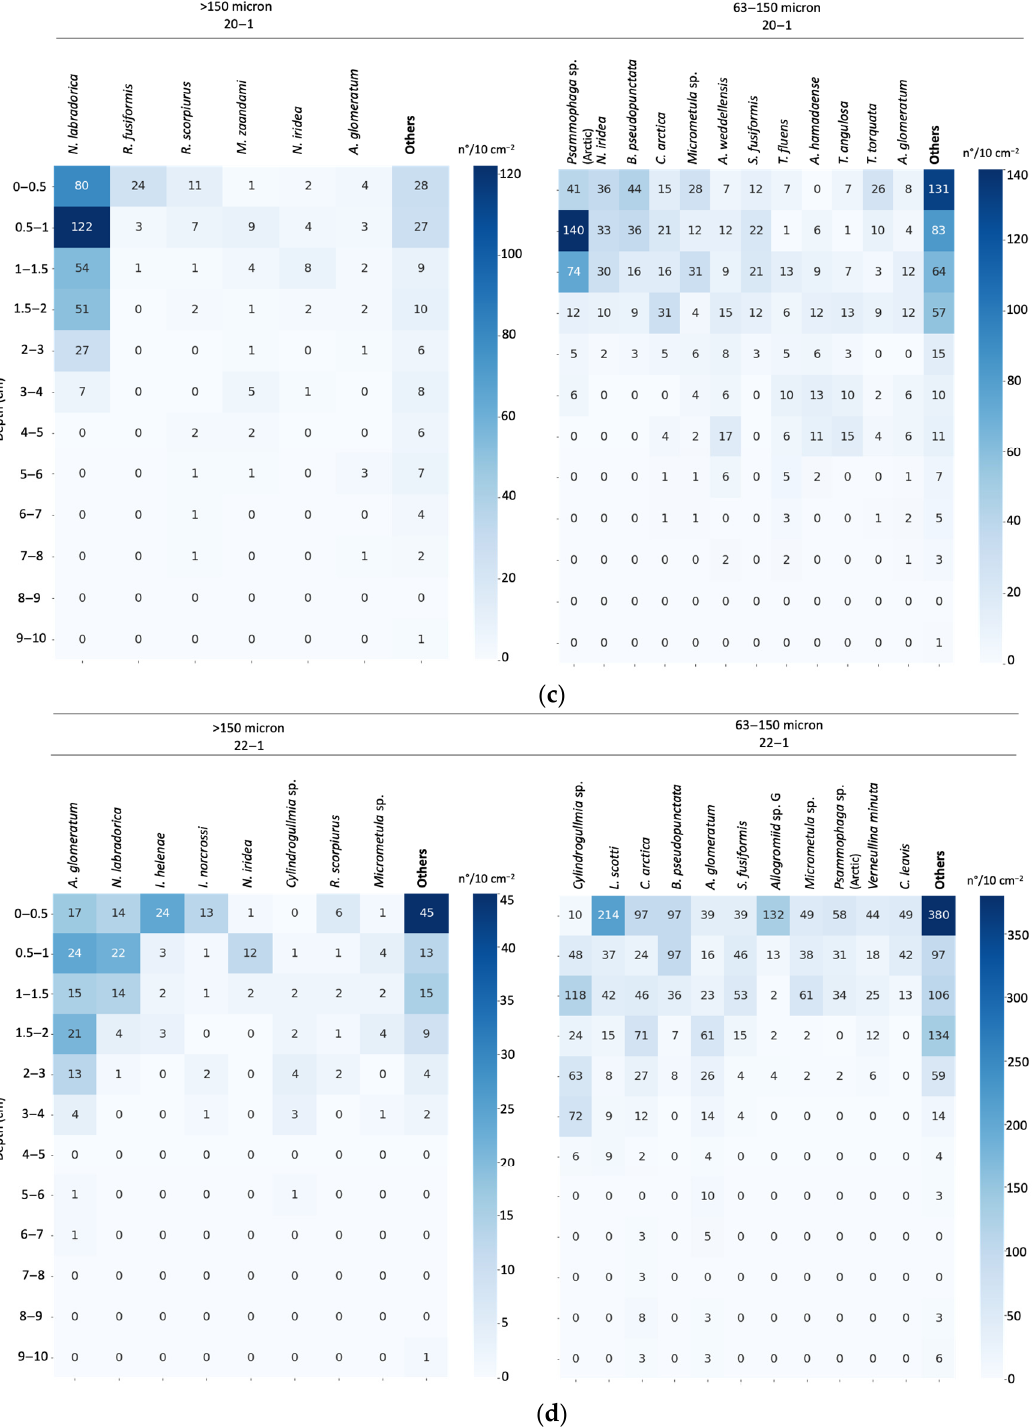
Figure 7. Vertical distribution of foraminifera for the size fraction >150 µ m and 63–150 µ m. Data are expressed as number of foraminifera per area (n ◦ /10 cm − 2 ). Only species more representative are shown (>10 ind./10 cm − 2 ); “others” group includes the sum of species with the lowest density. ( a ) site 01; ( b ) site 07. Vertical distribution of foraminifera for the size fraction >150 µ m and 63–150 µ m. Data are expressed as number of foraminifera per area (n ◦ /10 cm − 2 ). Only species more representative than this are shown (>10 ind./10 cm − 2 ); “others” group includes the sum of species with the lowest density. ( c ) site 20; ( d ) site 22.